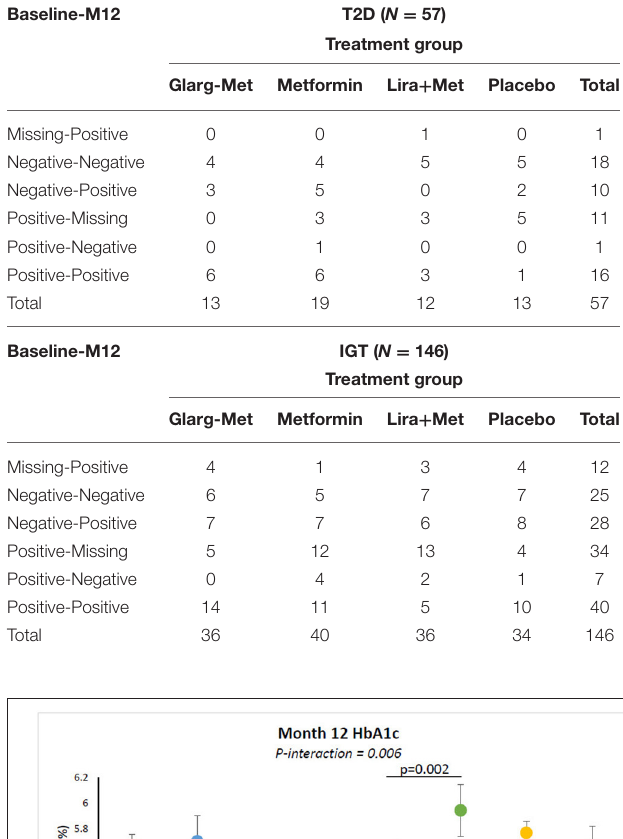
TABLE 4 | Categories of T cell status change by diabetes status and treatment group. Baseline-M12